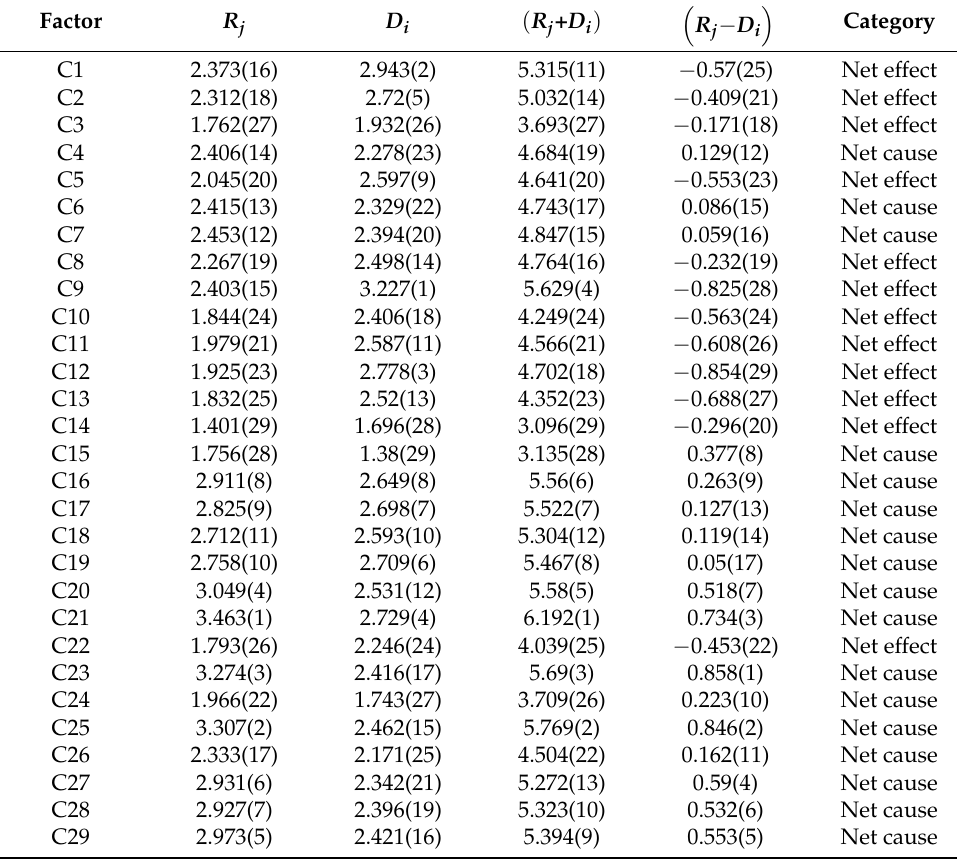
Table 6. The affected degree ( R j ) , influence degree ( D i ) , centrality ( R j + D i ) and cause-effect degree (cid:16) (cid:17) R j − D i for each